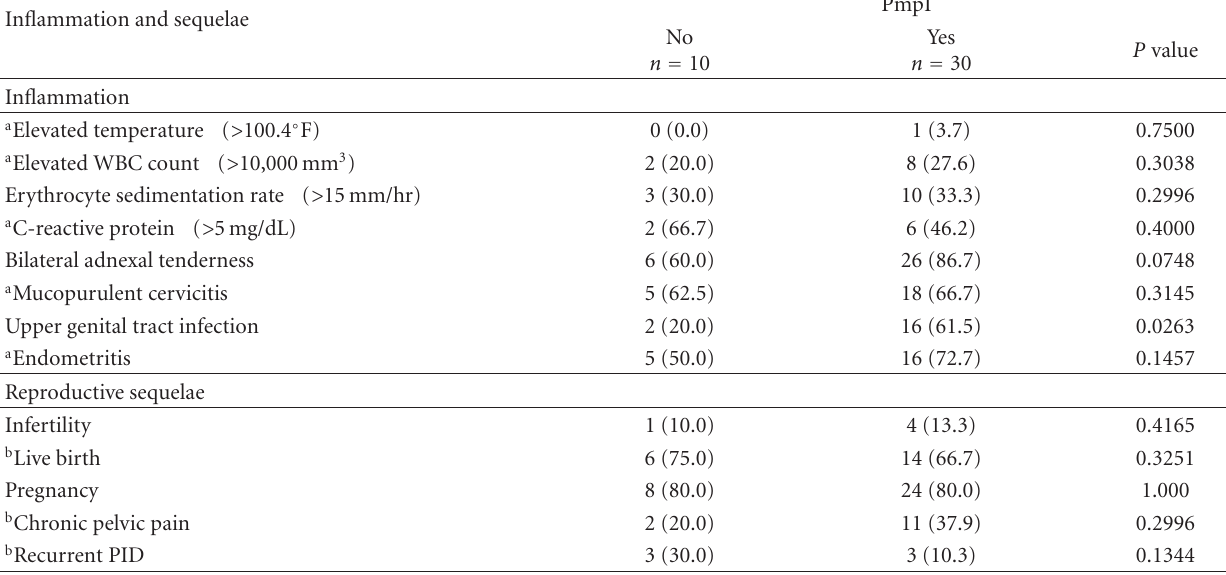
Table 4: Frequency of baseline inflammatory markers and reproductive sequelae by PmpI antibody expression. Inflammation and sequelae